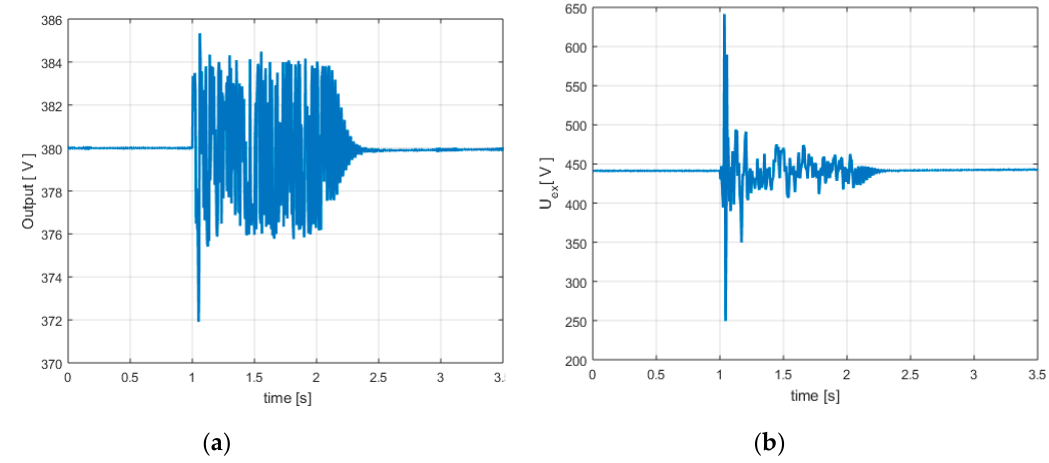
Figure 13. Resistive load—3rd order model: ( a ) Terminal voltage (controlled output); ( b ) Excitation voltage (controller